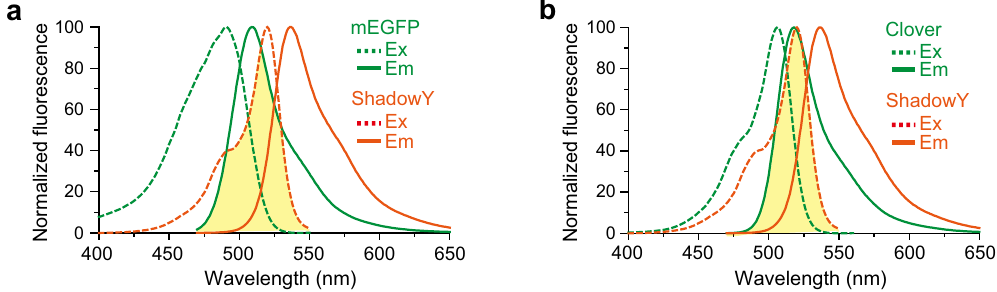
Figure 3. The spectral overlap of fluorescent proteins. ( a , b ) The spectral overlap (yellow region) between ShadowY’s excitation spectrum and mEGFP’s ( a ) or Clover’s ( b ) emission